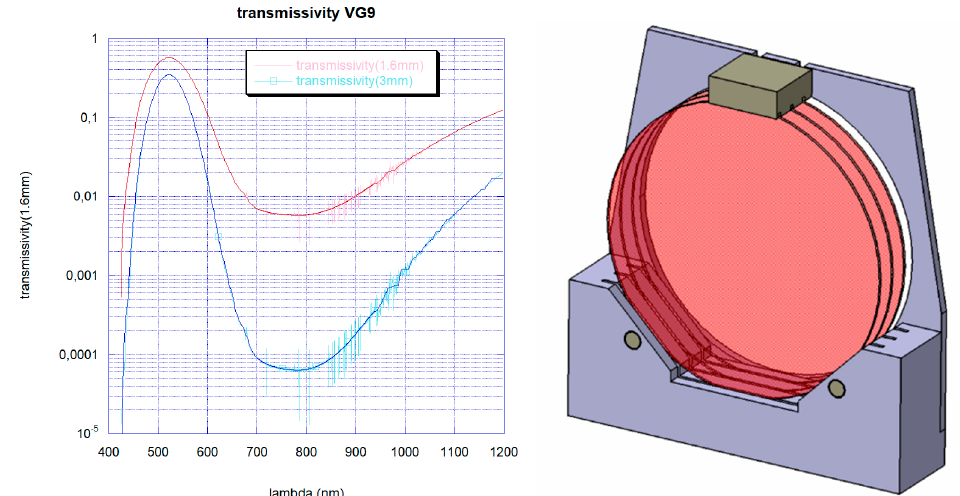
Figure 14. ( Left ) VG9 transmission spectra, measured with a 3-mm thick sample (blue curve) and a 1.6-mm thick sample (red curve). ( Right ) Mounting for the VG9 filters. Filter diameter is 160 mm, thickness 1.6 mm.